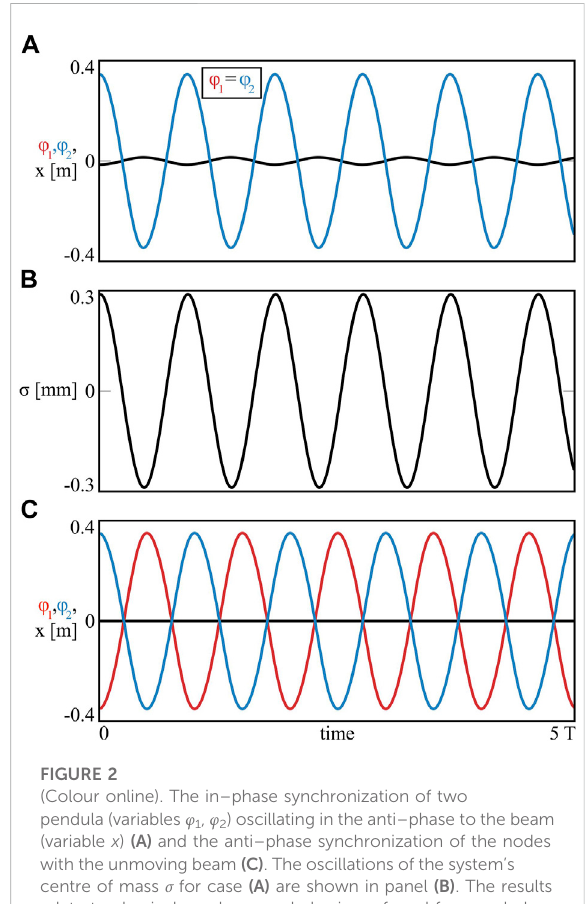
FIGURE 2 (Colour online). The in – phase synchronization of two pendula (variables φ 1 , φ 2 ) oscillating in the anti – phase to the beam (variable x ) (A) and the anti – phase synchronization of the nodes with the unmoving beam (C) . The oscillations of the system ’ s centre of mass σ for case (A) are shown in panel (B) . The results relate to classical synchronous behaviours found for coupled oscillators. System (1) with n = 2 ( m 1 = m 2 = 1.0